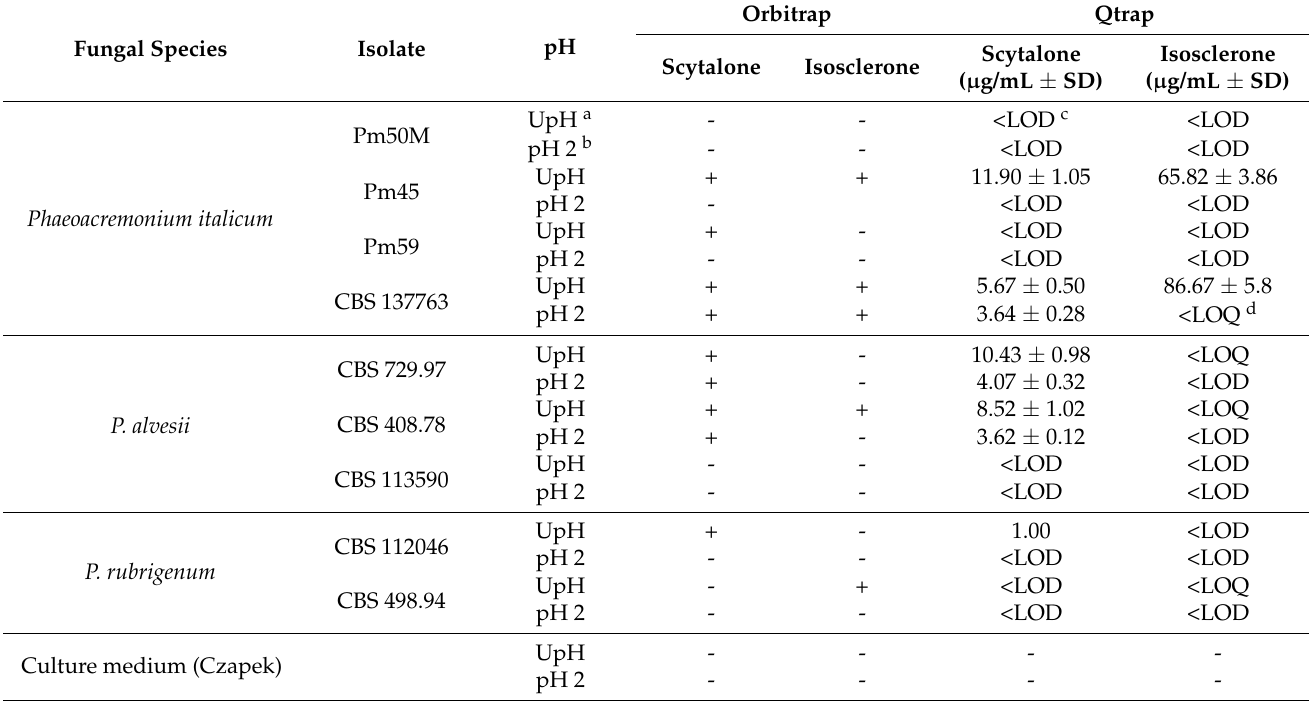
Table 4. Identification and quantification of scytalone ( 1 ) and isosclerone ( 2 ) by LC-MS/MS analysis.